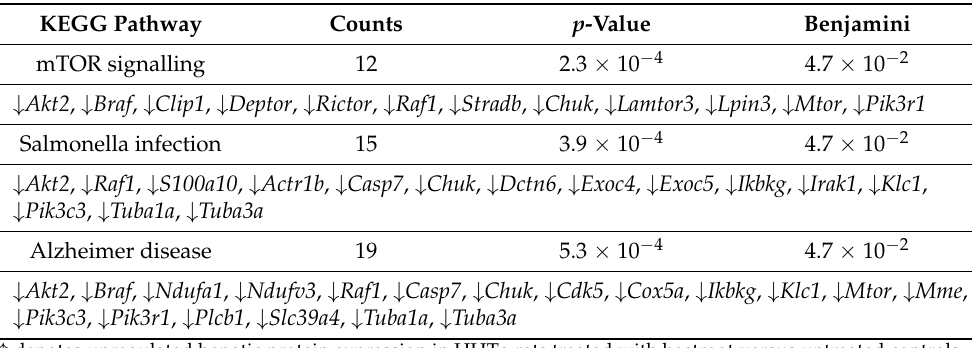
Table 5. Genes from significant KEGG pathways coding for differential hepatic expression of proteins in HTTg rats treated with beetroot juice versus HTTg untreated